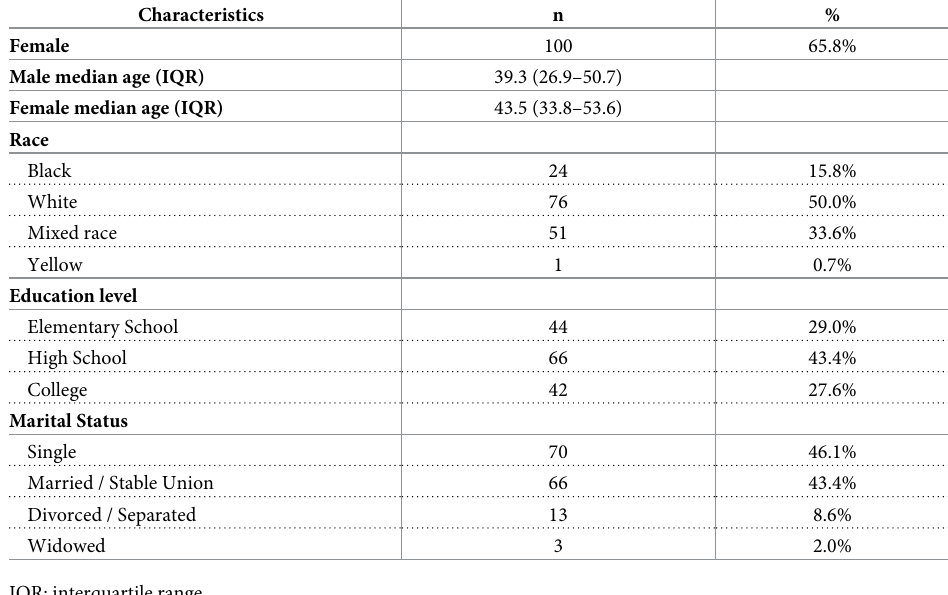
Table 1. Sociodemographic characteristics of the study population, April—December 2019, Rio de Janeiro, Brazil.